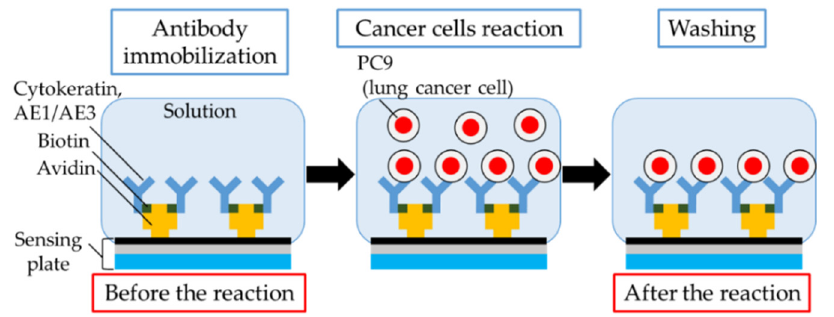
Figure 3. Schematic diagram of an experimental process to detect cancer cells in solution. After immobilizing the AE1/AE3, the distribution of the terahertz amplitude was measured as a background signal. In this study, cultivated human lung adenocarcinoma cells (PC9) were used as sample cells. The concentrations of cancer cells in the culture medium were 10 3 , 10 4 , and 10 5 cell/mL, which were measured using an automated cell counter (Countess 2, Thermo Fisher Scientific, Tokyo, Japan). Figure 4a,b show the sensing plate with four wells and the cross-section of the sensing plate, respectively. The sample solutions with cells were infected in each well at a volume of 30 µ L. The concentration of cells is shown in Figure 4a. The cells were incubated with the immobilized antibodies for 15 min at room temperature at 45 rpm. Thereafter, the non-reacted cancer cells were removed by washing 10 times. The distribution of the terahertz amplitude after reacting the cancer cells was measured using the TCM.